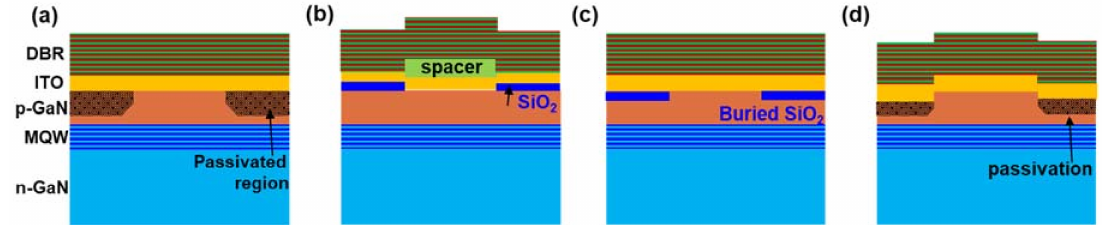
Figure 10. Schematic aperture designs with ( a ) ion-implantation or plasma passivation ( b ) additional spacer ( c ) buried SiO 2 and ( d ) plasma etched and passivated cladding region for lateral optical confinement.